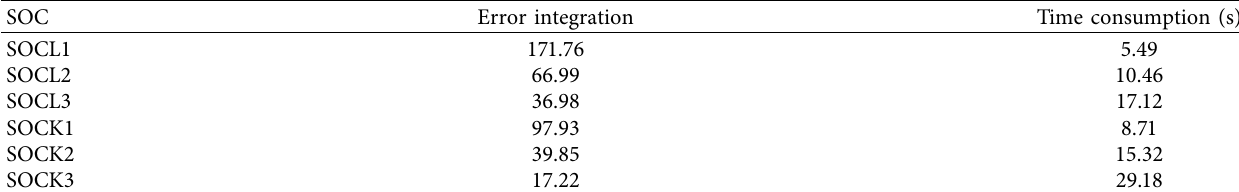
Table 4: The estimation accuracy and complexity of SOCL and